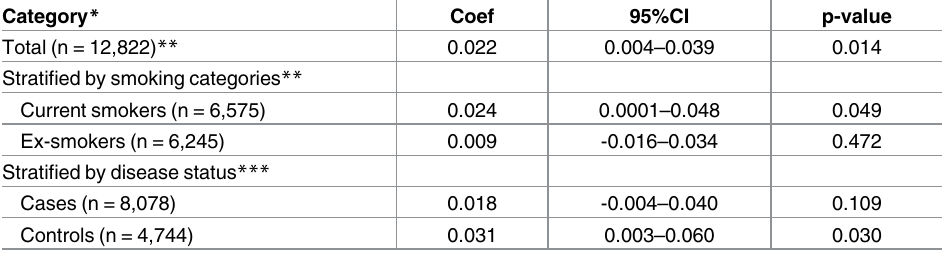
Table 3. Partial correlations between pack-years of smoking and